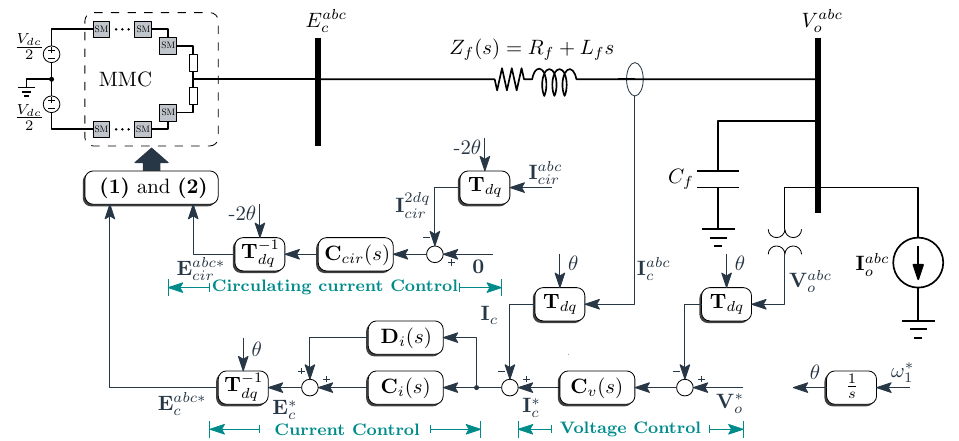
Figure 2. Control block diagram of the grid forming